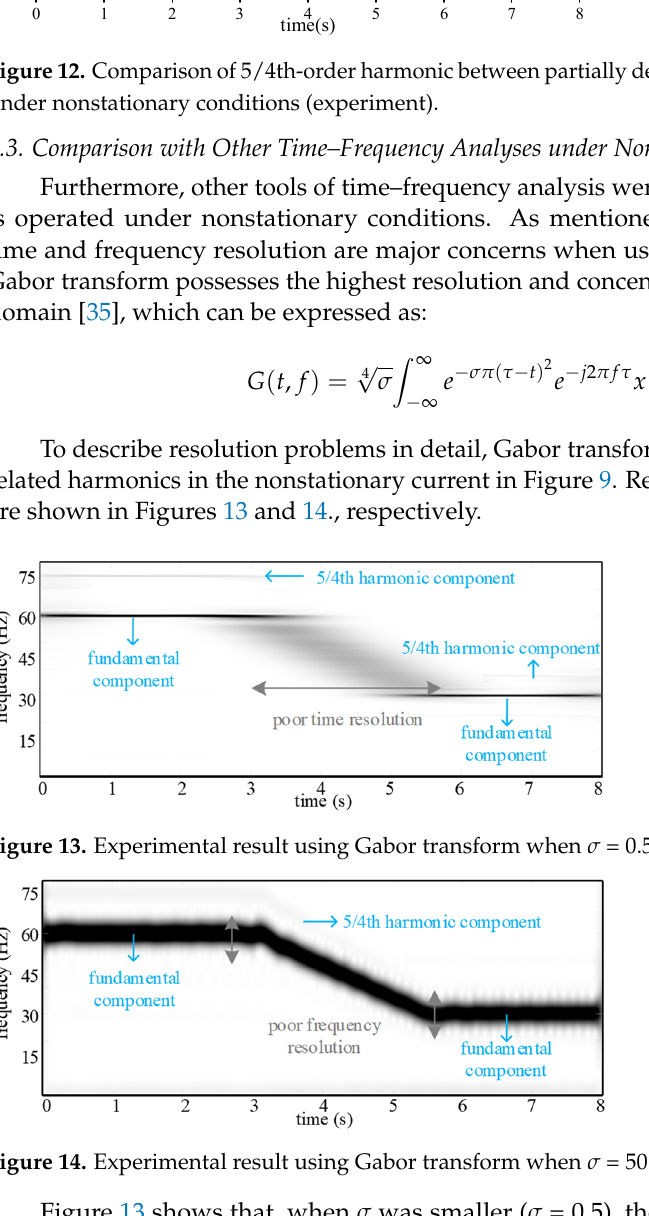
Figure 12. Comparison of 5/4th-order harmonic between partially demagnetized and healthy PMSMs under nonstationary conditions (experiment).